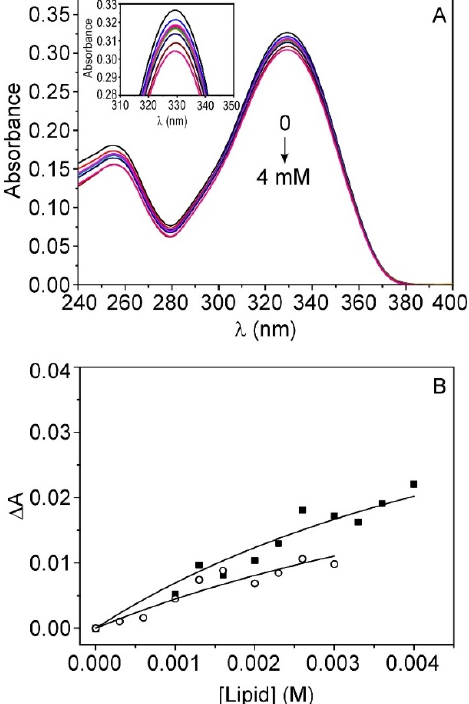
Figure 2. ( A ) Absorption spectrum of TMZ (150 μ M) in water in presence of egg 1,2-diacyl-sn-glycero-3-phosphocholine (EPC) Large unilamellar vesicles (LUVs), at increasing lipid concentrations, up to 4 mM. Inset: Amplified image. ( B ) Changes observed in the absorbance values of TMZ at 329 nm ( ∆ A), at increasing EPC (black square) and EPC:Chol (3:1) (circle) lipid concentration. Solid lines represent fitting curves to Equation (8).